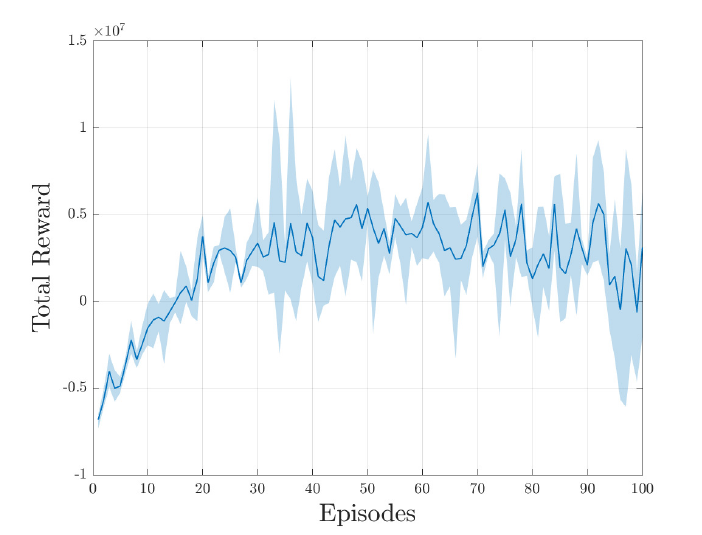
Figure 4. Total reward per episode during